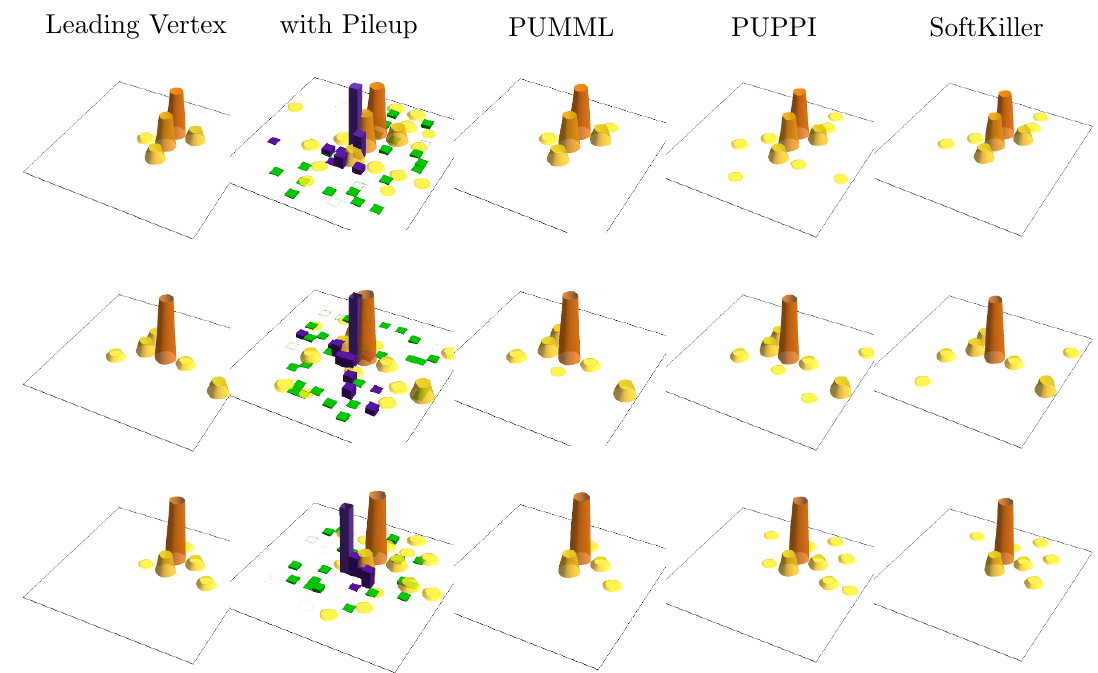
Figure 3 . Depictions of three randomly chosen leading jets. Blue/purple represents charged radiation from the leading vertex, green is charged pileup radiation, and yellow/orange/red is the neutral radiation. Shown from left to right are the true neutral leading vertex particles, the event with pileup and charged leading vertex information, followed by the neutral leading vertex particles predicted by PUMML, PUPPI, and SoftKiller. From examining these events, it appears that PUMML has learned an e(cid:11)ective pileup mitigation